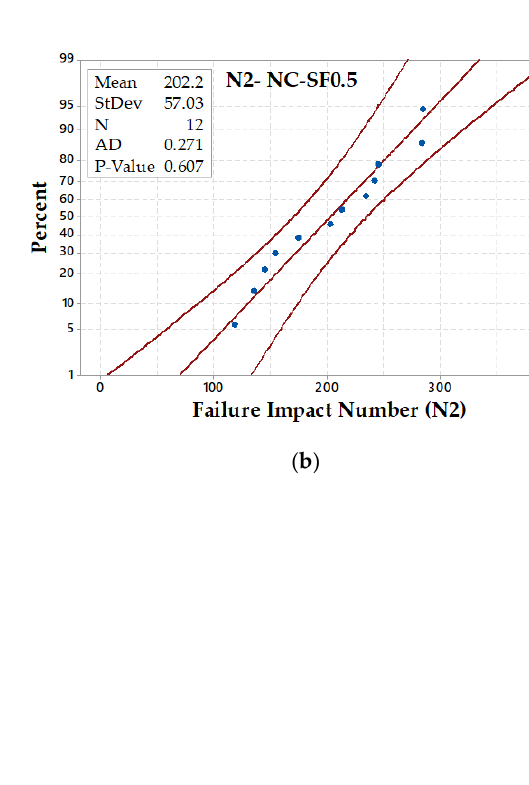
( d ) ( d ) Figure 11. Normal probability plots of the results at the failure stage for mixtures ( a ) NC ( b ) NC-SF0.5 ( c ) NC-SF1.0 and ( d ) HC. 5. Weibull Distribution During the preliminary phases of the investigation into the impact strength of con- crete, scientists discovered that the ACI 544-2R repeated drop-weight test was distinct. Despite the significant amount of work put into creating equal testing settings, the find- ings of the tests were clearly distinguishable. As a result, statistical analysis seemed nec-